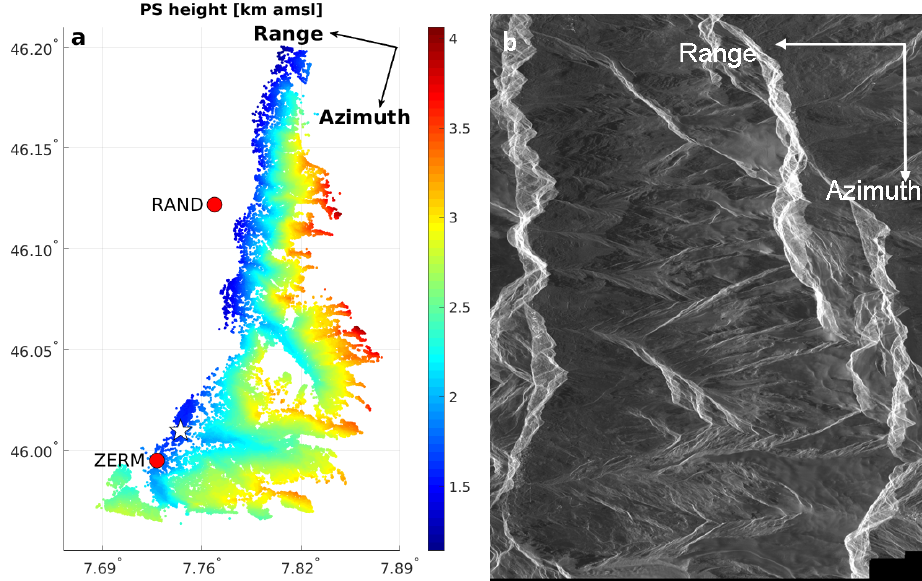
Figure 5. ( a ) The height distribution of the 326,552 PS points. The white star indicates the reference point and the red dots represent the GNSS stations situated within our area of interest ( b ) the average intensity of the SAR image in radar